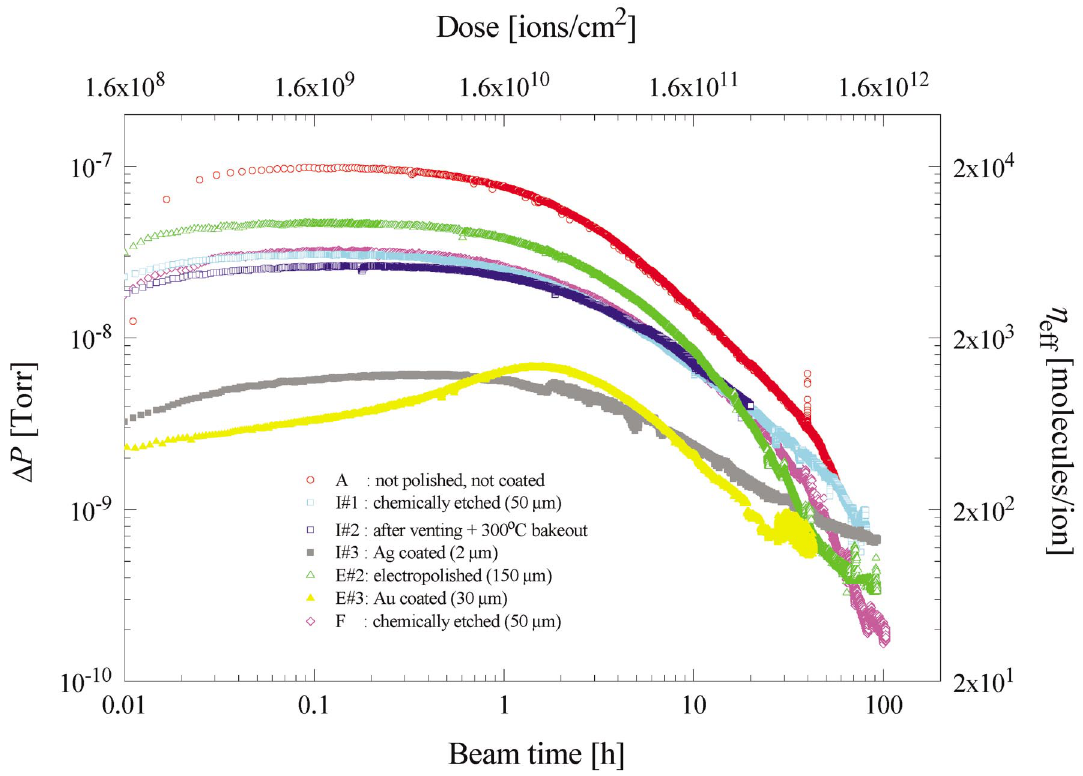
FIG. 4. (Color) Beam cleaning measurements for four different 316 LN stainless steel vacuum chambers continuously bombarded with (cid:4) 1 : 5 (cid:1) 10 9 Pb 53 (cid:2) ions (per shot) under (cid:8) (cid:6) 89 : 2 (cid:7) grazing incidence. The results obtained for a chemically etched vacuum chamber